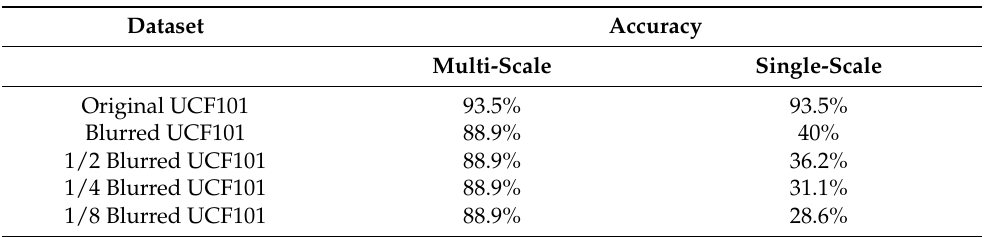
Table 1. TSN performance comparison comparing our multi-scale algorithm vs. a single-scale global Gaussian blur.